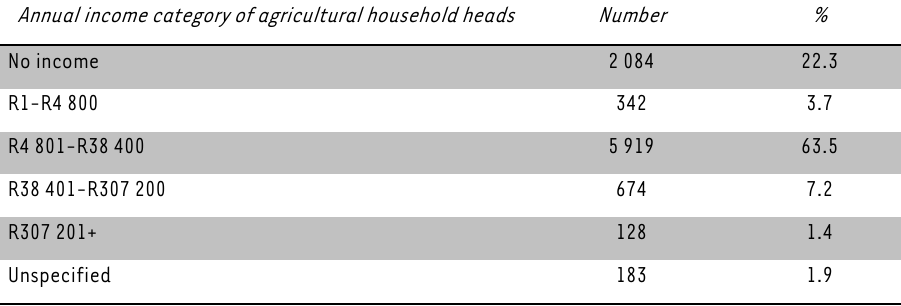
TABLE 4: Income Category of Agricultural Household Heads in uMshwathi Annual income category of agricultural household